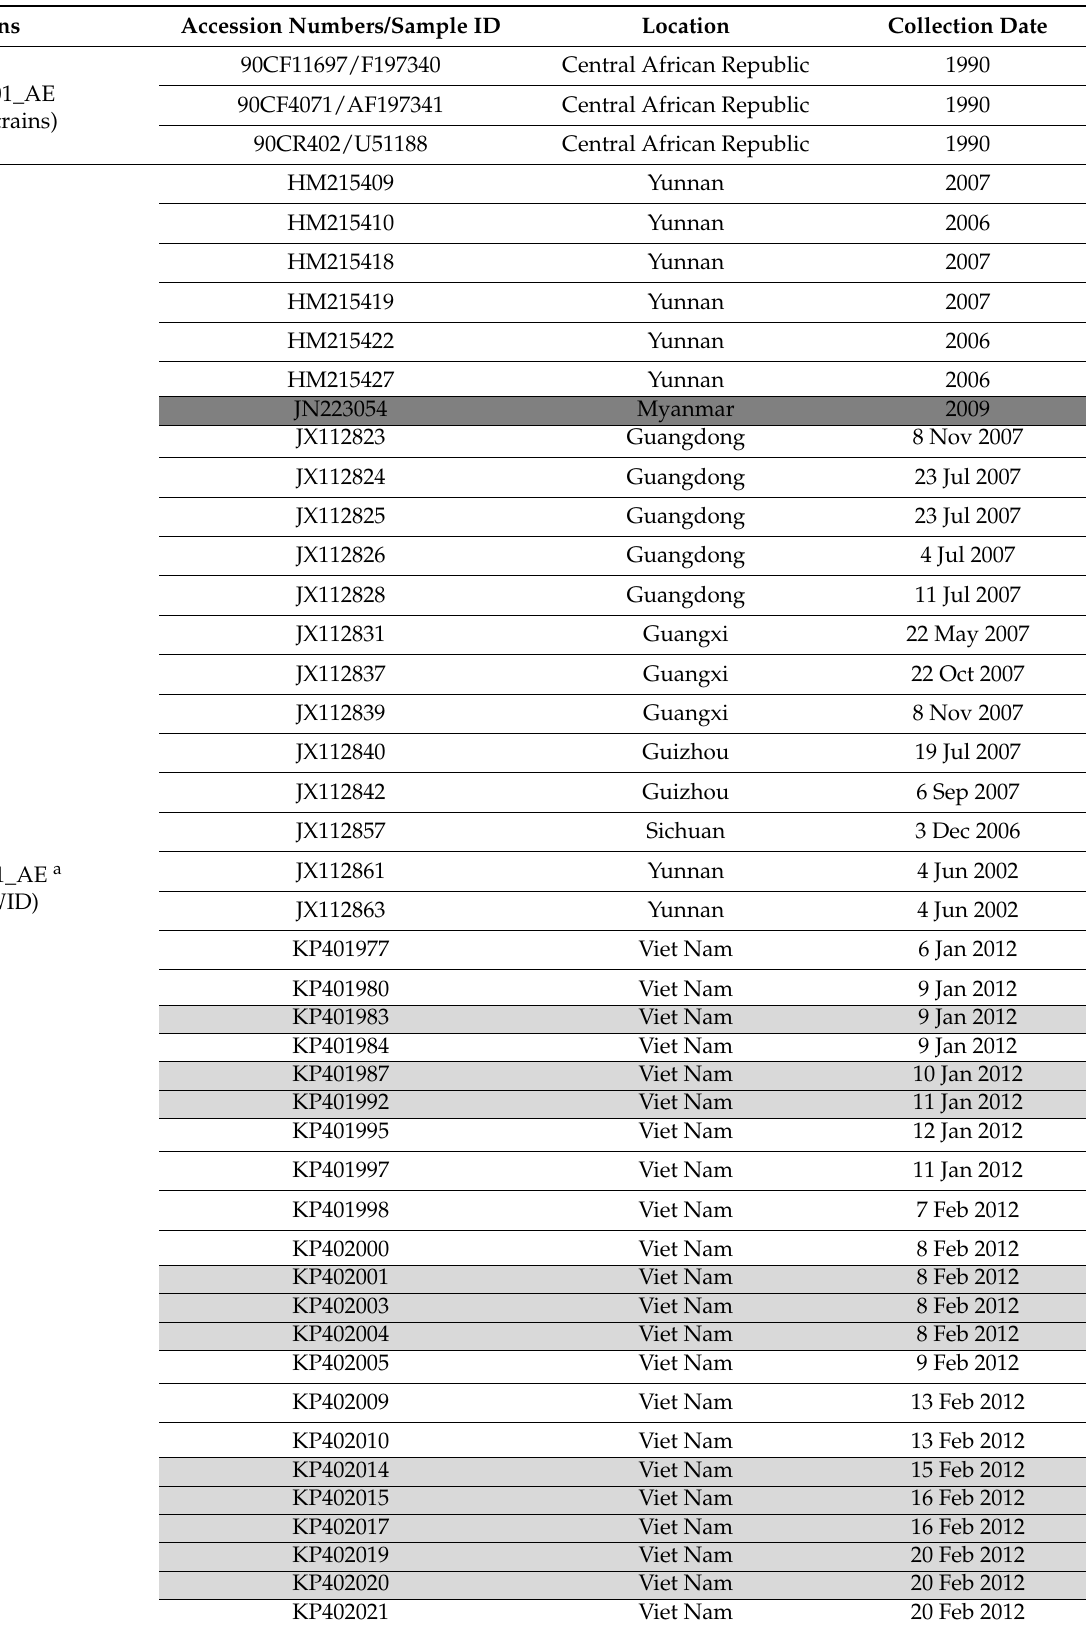
Table A2. Location and collection date of Asian isolates from PWID infected with HIV-1 CRF01_AE, CRF07_BC, and HCV-6 and other related reference strains from